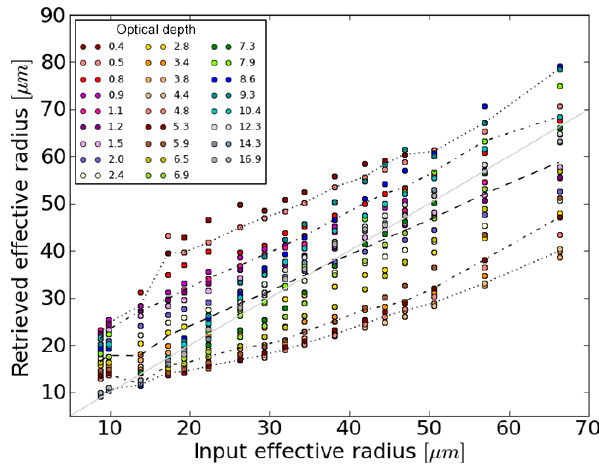
Figure 6. Sensitivity to ice crystal habit (test 4d of Table 1): scatter plot for the effective radius retrieval, assuming the habit mixture. Test spectra are simulated for bullet rosettes with τ , r eff , θ 0 and θ v not included in the lookup tables. Dashed lines indicate P r, 2 . 5 and P r, 97 . 5 (according to 95% of all absolute errors); dash-dotted lines indicate ± R r ; dotted lines are the means for the test cases shown: θ 0 = 31.75 ◦ , θ v = 2.25 ◦ , φ rel = 180 ◦